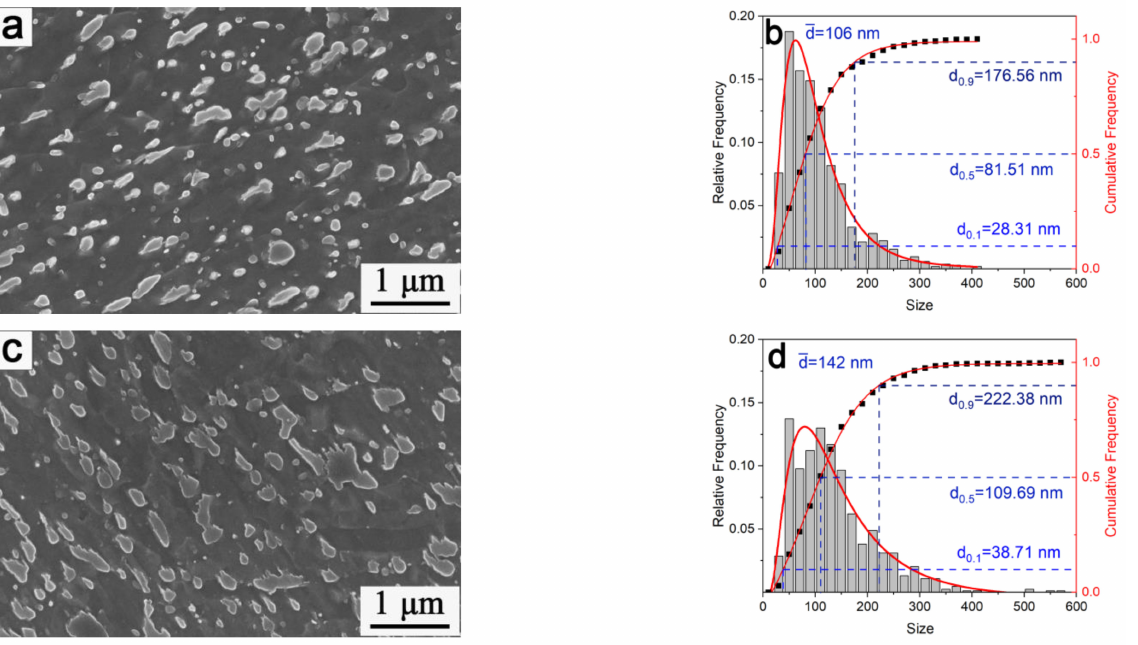
Figure 9. SEM and size distribution of precipitates after aging at 650 ◦ C for 128 h: ( a , b ) 900-II; and ( c , d )